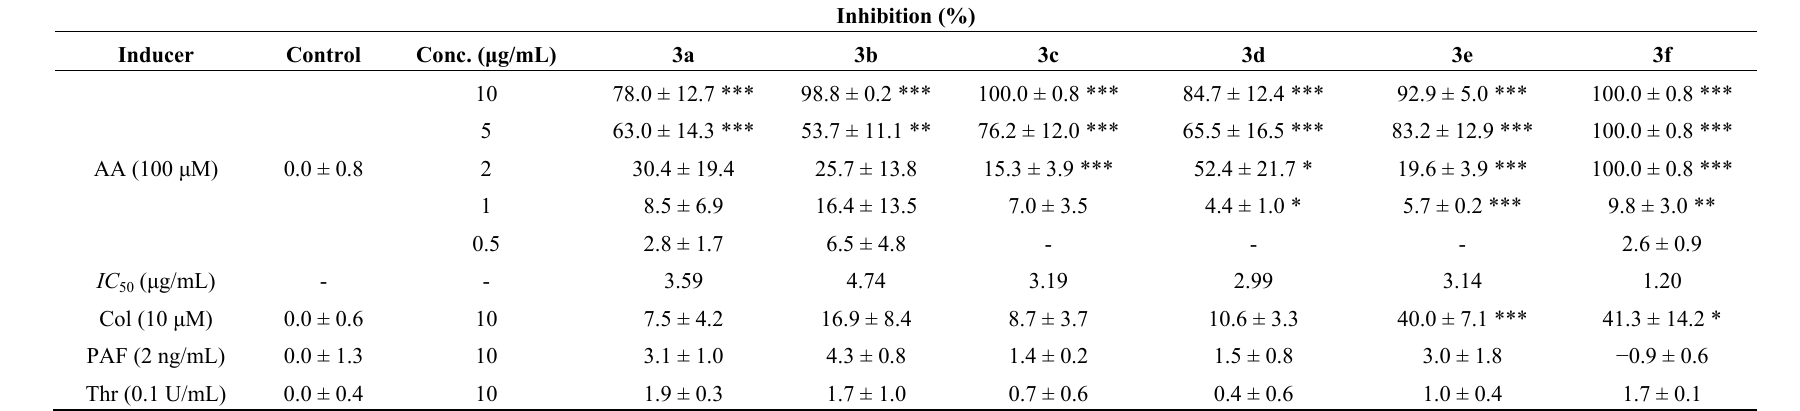
Table 11. Antiplatelet activity of [ n ]-dehydrogingerols 3a – f